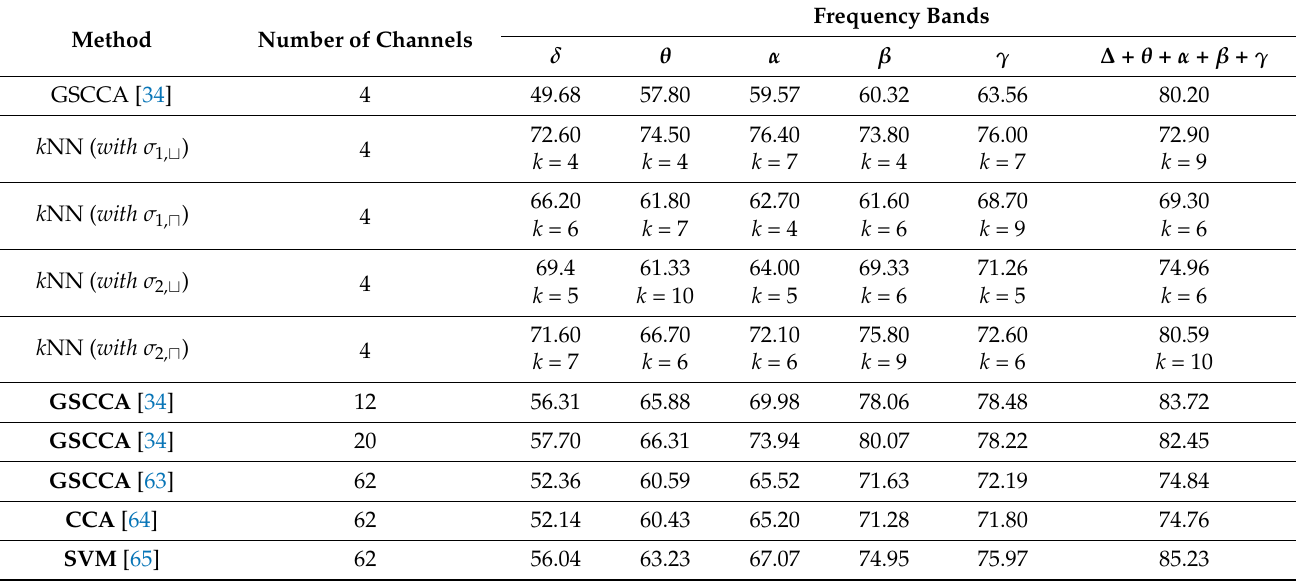
Table 3. Classification results (%) by various methods for different EEG channel numbers [34]. The proposed kNN (with σ ) classification results are also shown for the same four EEG channels as in